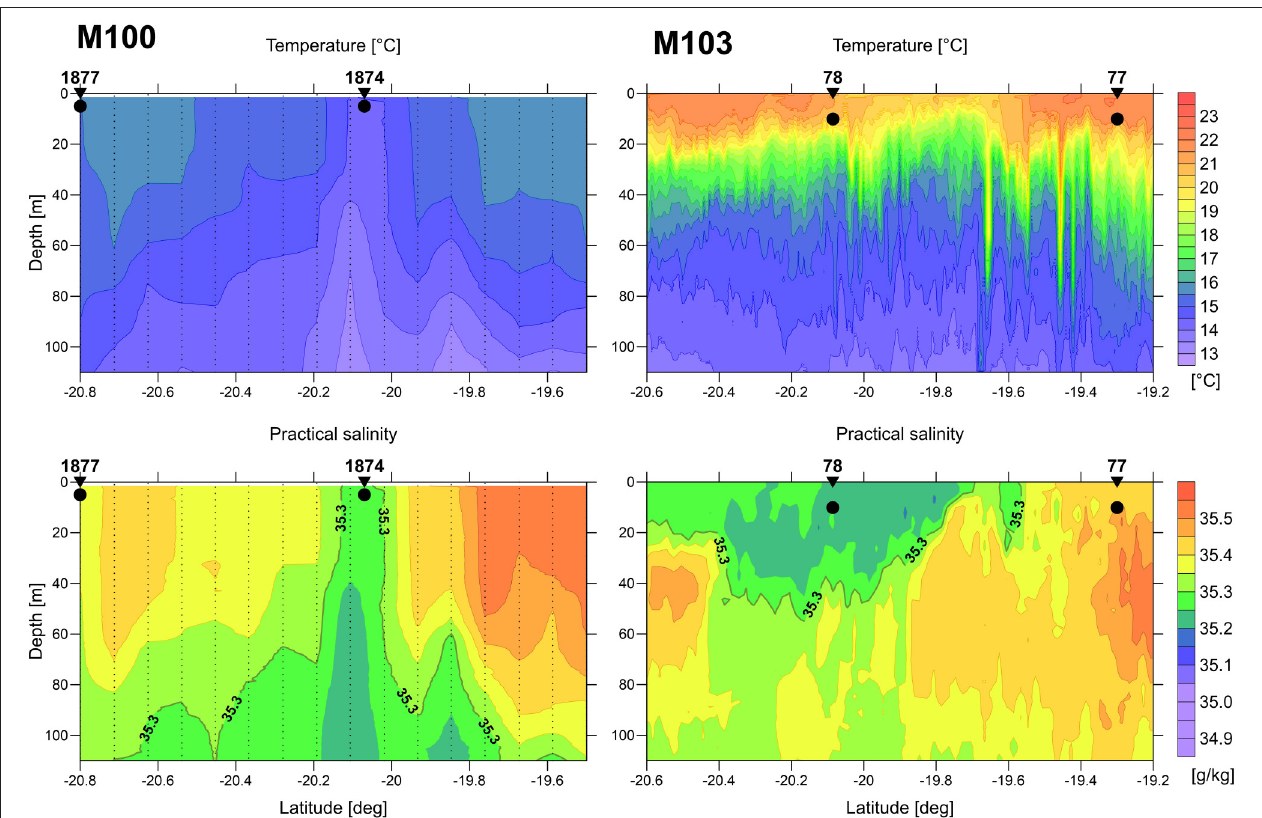
FIGURE 2 | Vertical distribution of temperature (top) and salinity (bottom) at transects across an upwelled water body (filament) during the main upwelling season (left: M100, microstructure profiler data) and austral summer (right: M103, undulating CTD data). The bold black dots indicate the water sampling positions and depth. The positions of the transects are indicated in Figure 1 .